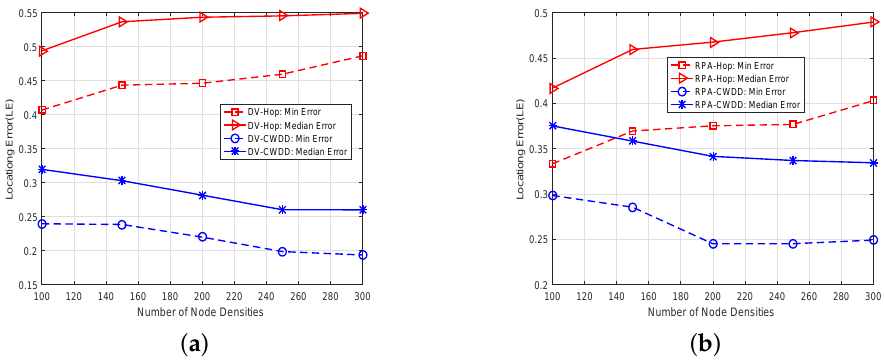
Figure 9. Different node densities: ( a ) Dv-based, ( b ) RPA-based.